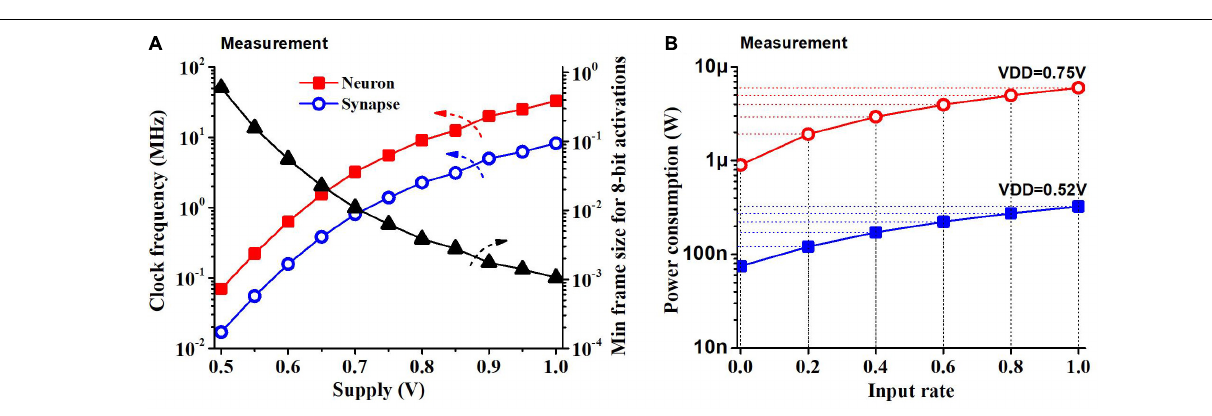
FIGURE 10 | (A) Clock frequency measurement and min frame length for 8-bit activations as a function of the supply voltage. Frame size is constrained by the latency of the SNN classifier (i.e., longer latency increases the minimum frame size). (B) Power consumption of the chip as a function of the input rate at two supply voltages. Power consumption increases linearly with the input